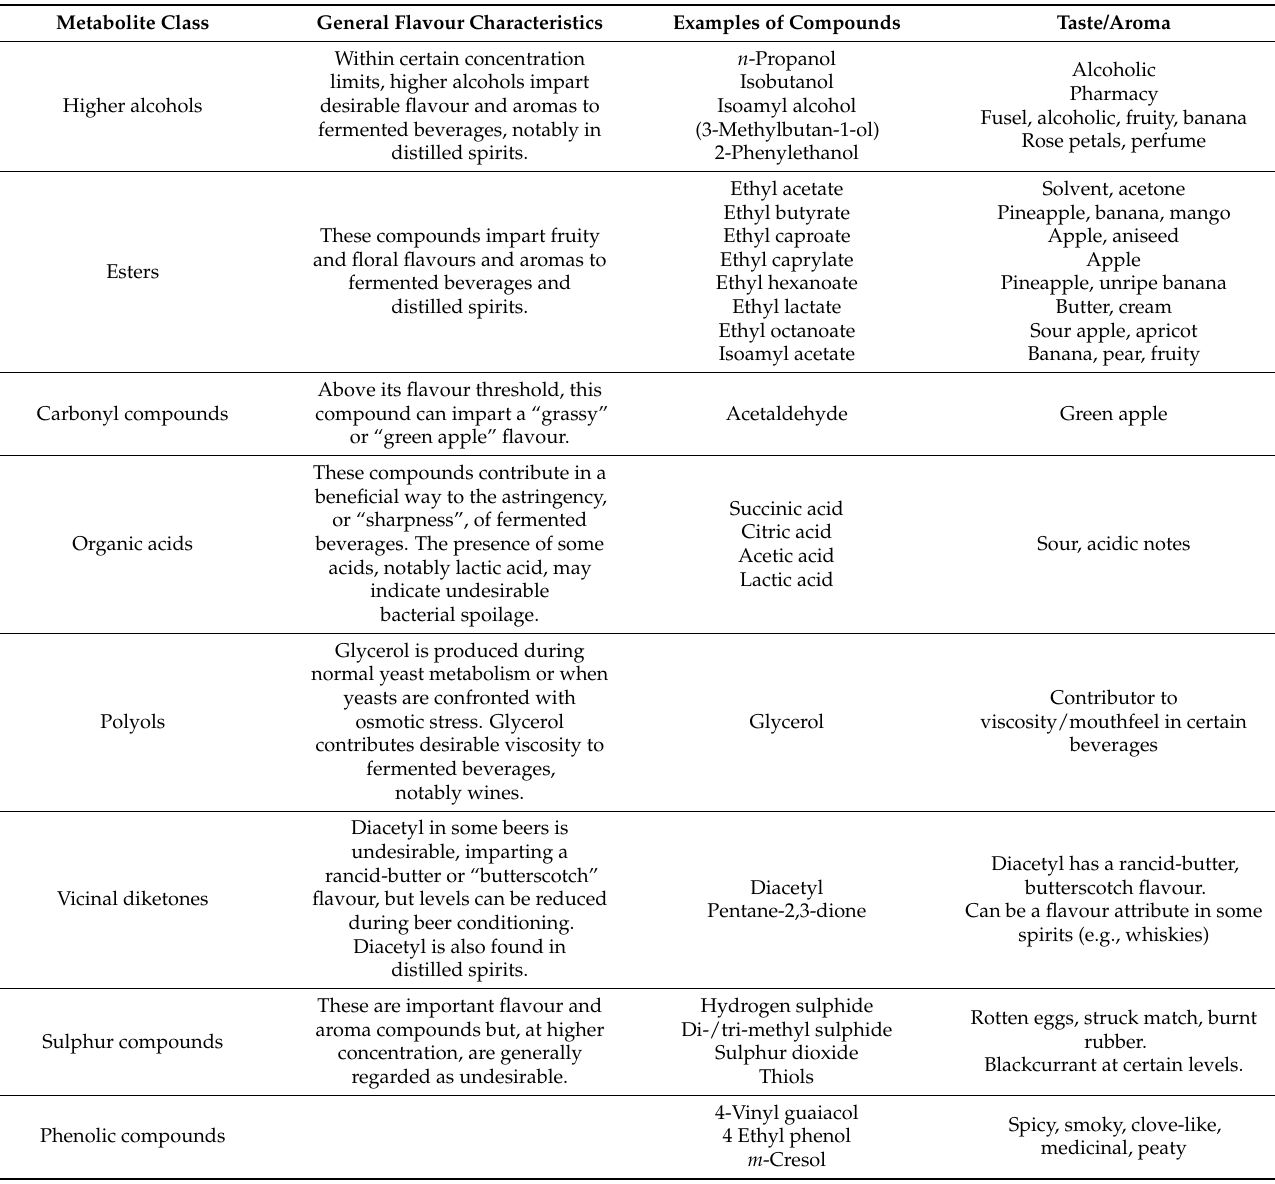
Table 7. Important yeast-derived flavour congeners in distilled spirits. (Adapted from